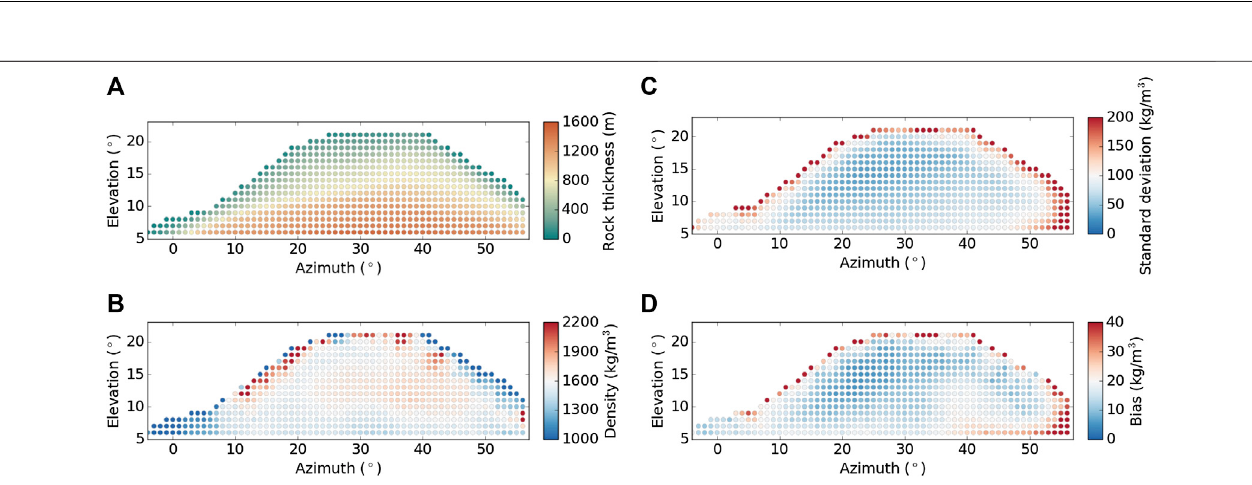
FIGURE 3 | Preliminary muographic data of the Puy de D ˆ ome volcano as observed from the Col de Ceyssat with the TOMUVOL detector and associated errors (C ˆ arloganuandtheTOMUVOLcollaboration,2018;Niessetal.,2018a).Thelocationofthemuondetectorisindicatedin Figure2 . (A) Thicknessofrockalongthemuon trajectories. (B) Averaged densities estimated from the muon count. (C) Statistical error (i.e., standard deviation). (D) Systematic error (i.e., bias).